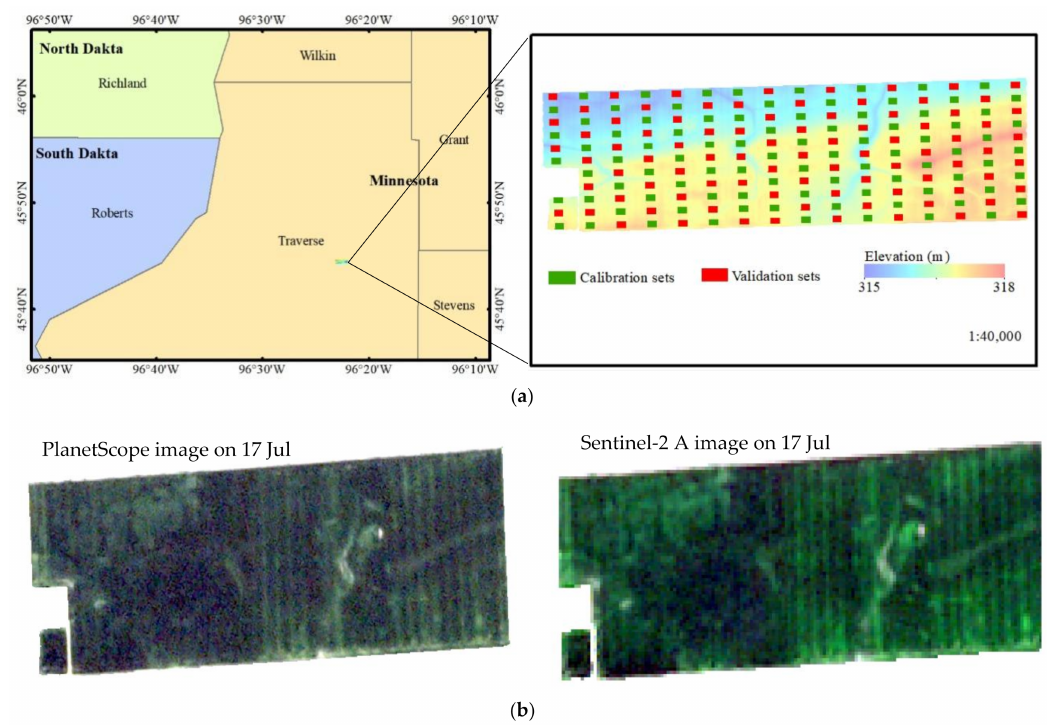
Figure 1. Location of the study area. ( a ) Study area and sample dataset distribution; ( b ) True color composite red-green-blue of PlanetScope (left) and Sentinel-2 A (right) images on 17 July 2018.